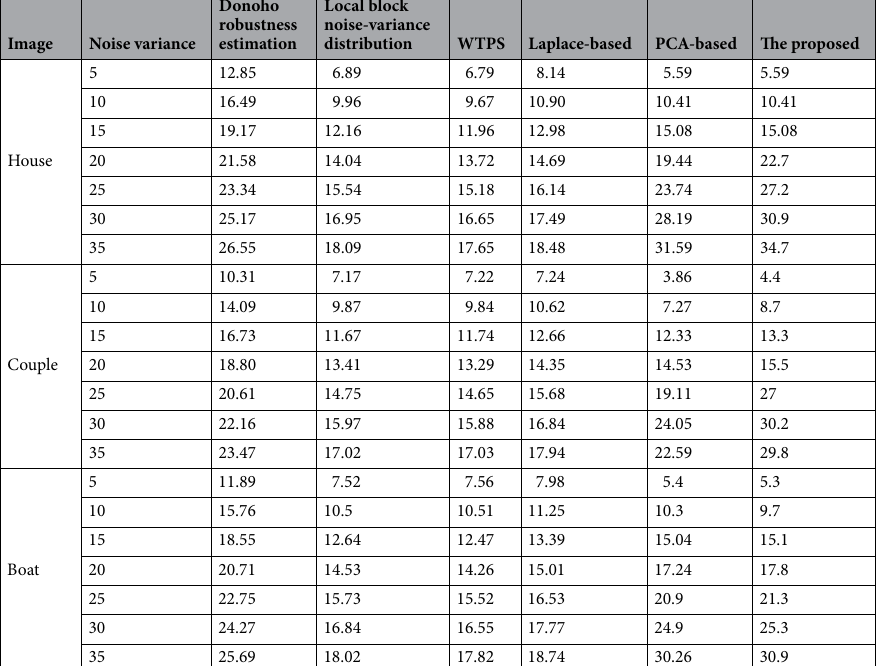
Table 3. The results of various noise-variance estimation